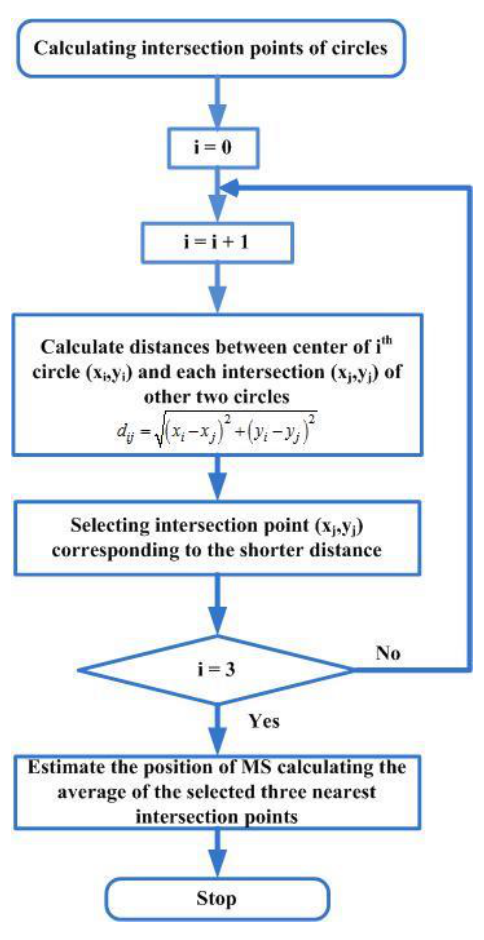
Figure 4. Flow chart for the shortest distance algorithm.